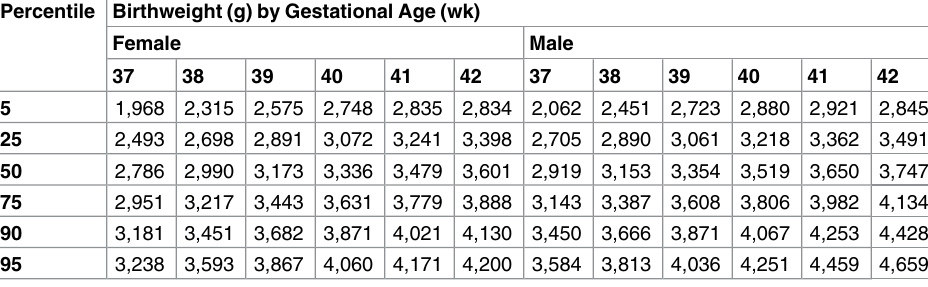
Table 4. Estimatedbirthweight percentiles for female and male neonates according to completed ges- tational week. Percentile Birthweight (g) by Gestational Age (wk)